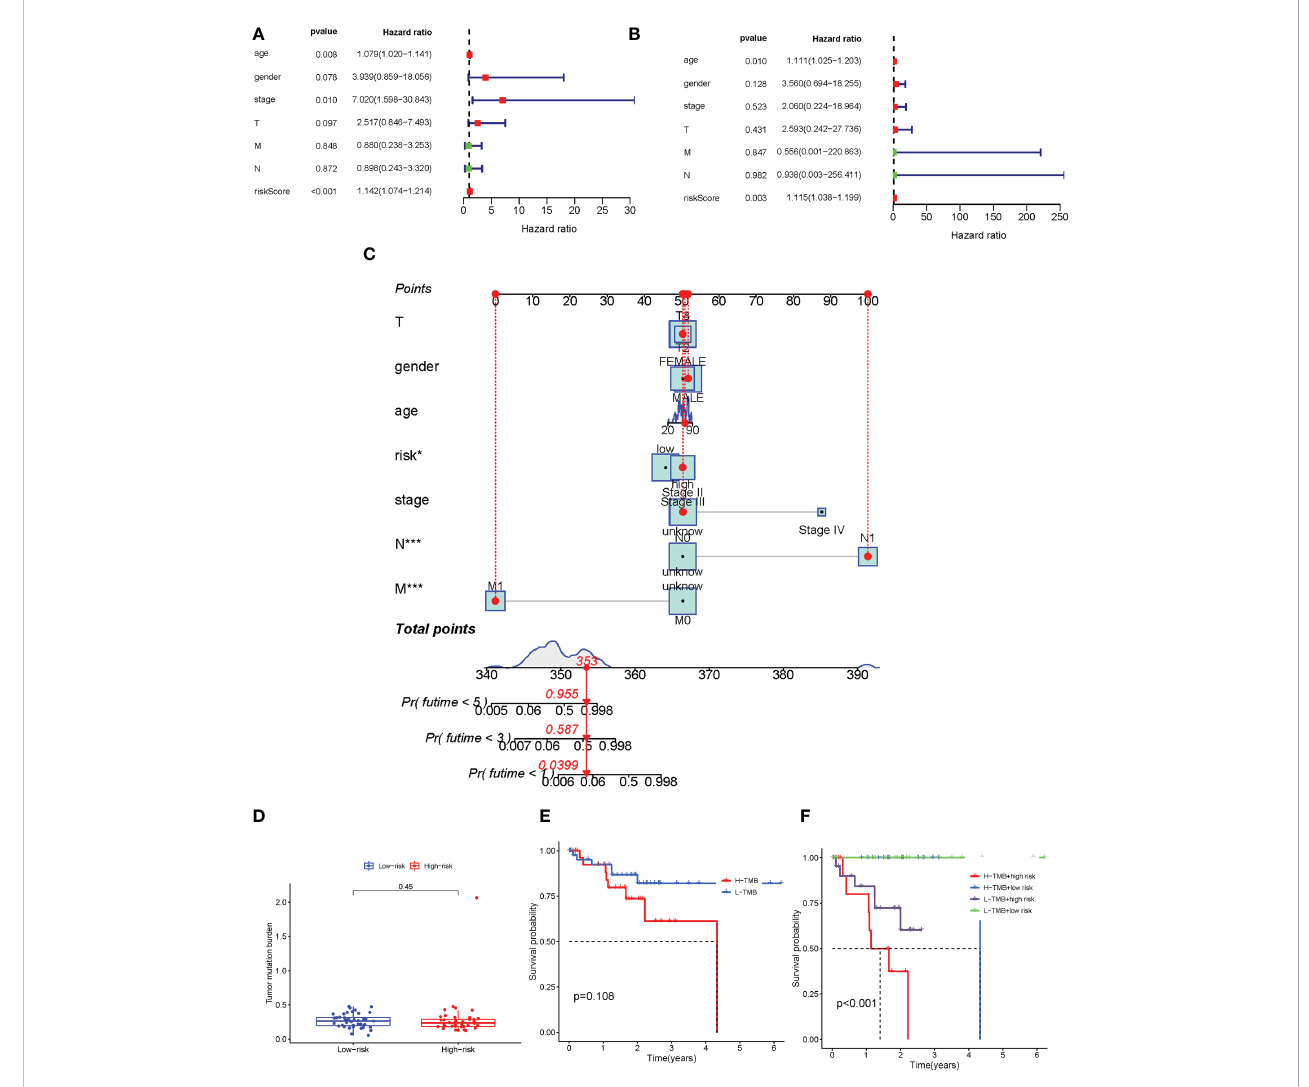
FIGURE 6 Evaluation TMB, prognostic factor, and the nomogram of the immune-related gene prognostic signature. (A-B) Univariate (A) and multivariate (B) Cox regression analysis evaluating the independent risk factors of the immune-related gene prognostic signature in uveal melanoma patients. (C) Development of a nomogram based on the immune-related gene prognostic signature in the TCGA training cohort. (D) The box plot for TMB levels for patients in the high- risk and low-risk groups. (E) Kaplan – Meier curves for the high-TMB and low-TMB of uveal melanoma patients. Log-rank test shows overall p = 0.108. (F) Kaplan – Meier curves for uveal melanoma patients in TMB status and combined in the high-risk and low-risk groups. Log-rank test shows overall p < 0.001. TMB, tumor mutational burden. *p < 0.05 and ***p <